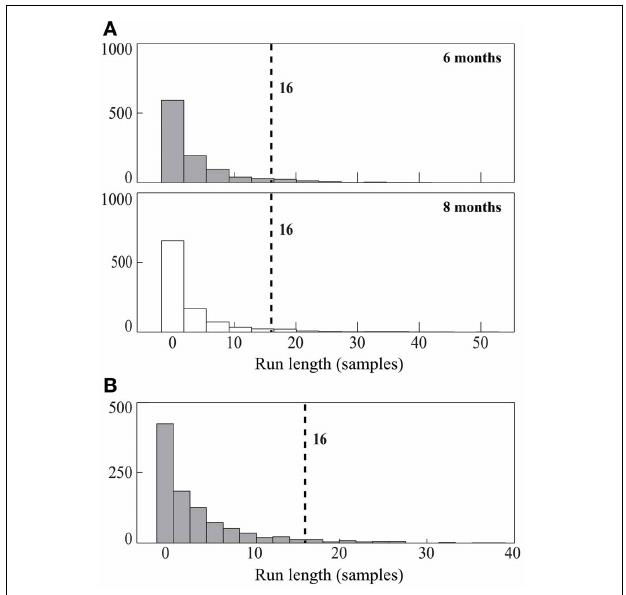
FIGURE 5 | Null distributions of maximal run length from each iteration of the permutation analyses for 6-month-old (gray bars) and 8-month-old (white bars) infants in Experiment 1 (A) and for 6-month-old infants in Experiment 2 (B). The 95% cutoff value is indicated by the number to the right of the dashed vertical